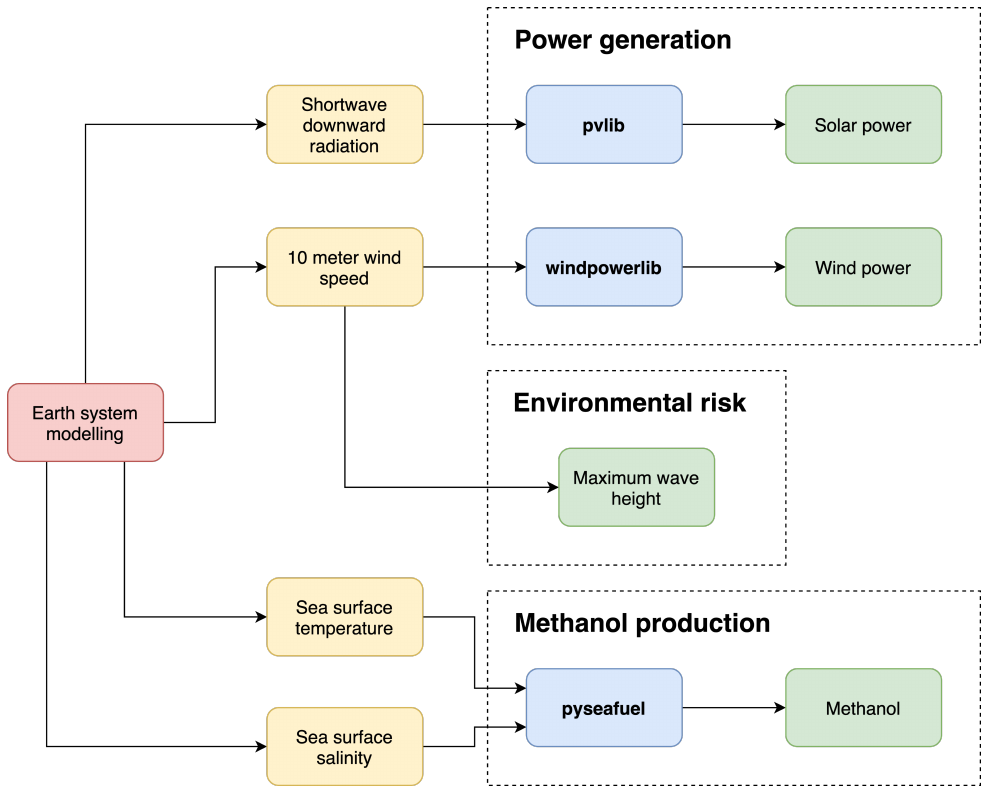
Figure 2. Earth system modelling provides shortwave downward radiation, 10 m wind speed and direction, sea surface temperature, and sea surface salinity. The shortwave downward radiation and 10 m wind speed are used to determine the power availability in the region. The 10 m wind speed is used to determine maximum wave height. The sea surface temperature and salinity are used to determine the methanol production.